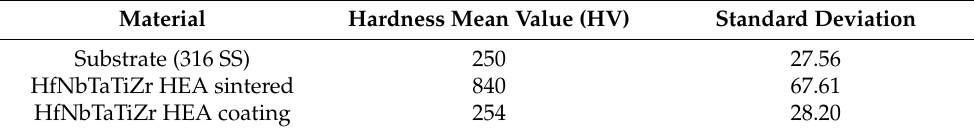
Table 3. Hardness mean value and the standard deviation for the tested